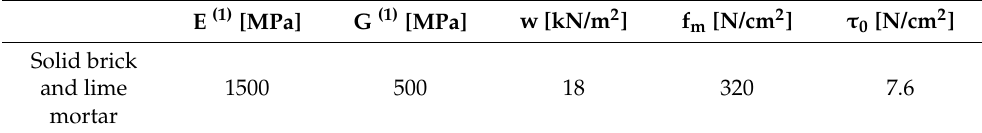
Table 2. Mechanical parameters assumed in the SEM